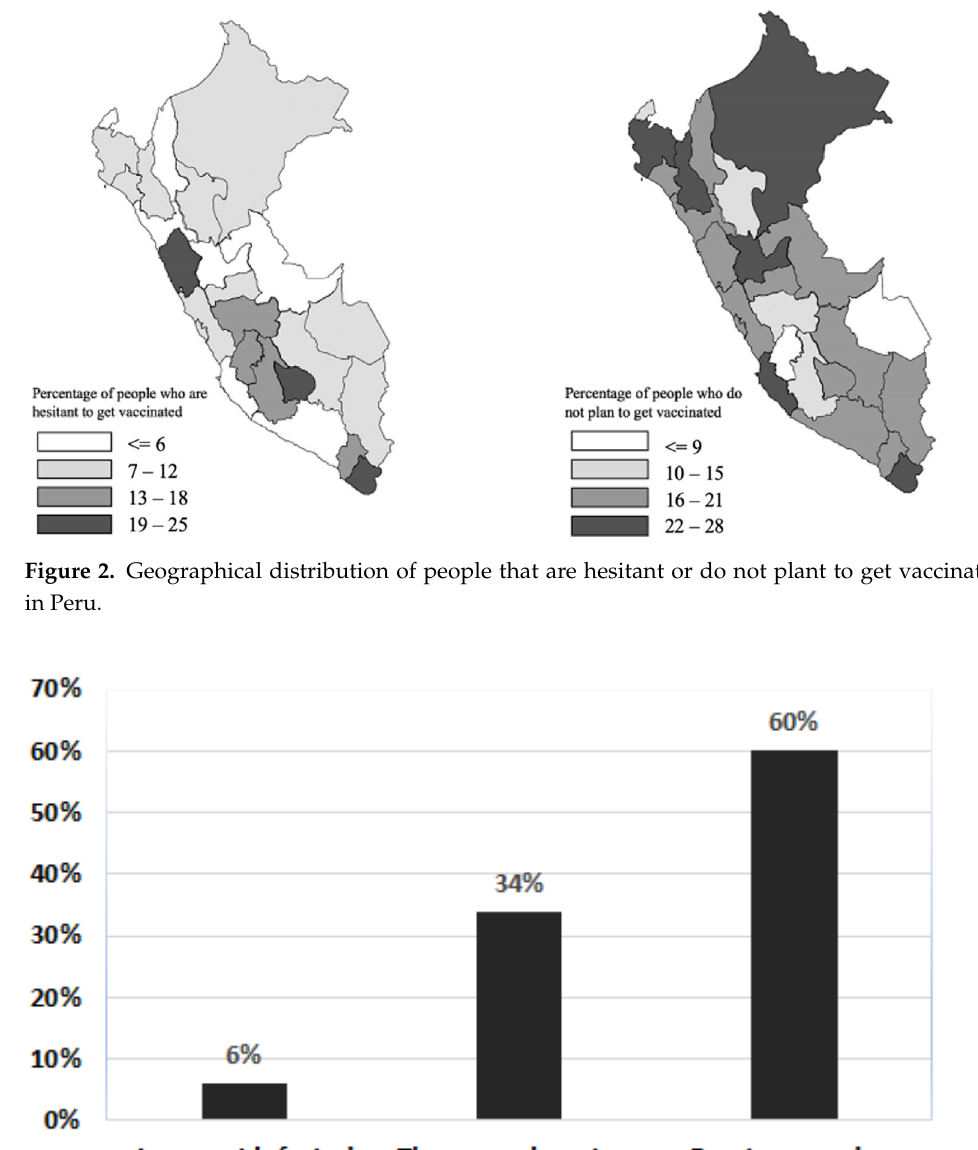
Figure 3. Reasons why people do not plan to be vaccinated against COVID-19 in Peru. As shown on Table 2, the bivariate analysis between the sociodemographic character- istics and the intent to get vaccinated, differences were found in regard to age ( p = 0.021), educational level ( p < 0.001), being a healthcare worker ( p < 0.001), having been sick with COVID-19 ( p < 0.001) or if their family or friends got sick ( p = 0.003). As shown on Table 3, when multivariate analysis (adjusted by department of residence) was performed, it was found that those who had a higher frequency of not wanting or not knowing if they were going to be vaccinated were those who did not know if they had been infected with COVID-19 (aPR: 1.40; 95% CI: 1.09–1.81; p -value = 0.008). In contrast, there was a lower frequency of refusal to the vaccine among university students (aPR: 0.75; 95% CI: 0.61–0.92; p -value = 0.005) and healthcare workers (aPR: 0.59; 95% CI: 0.44–0.80; p -value =